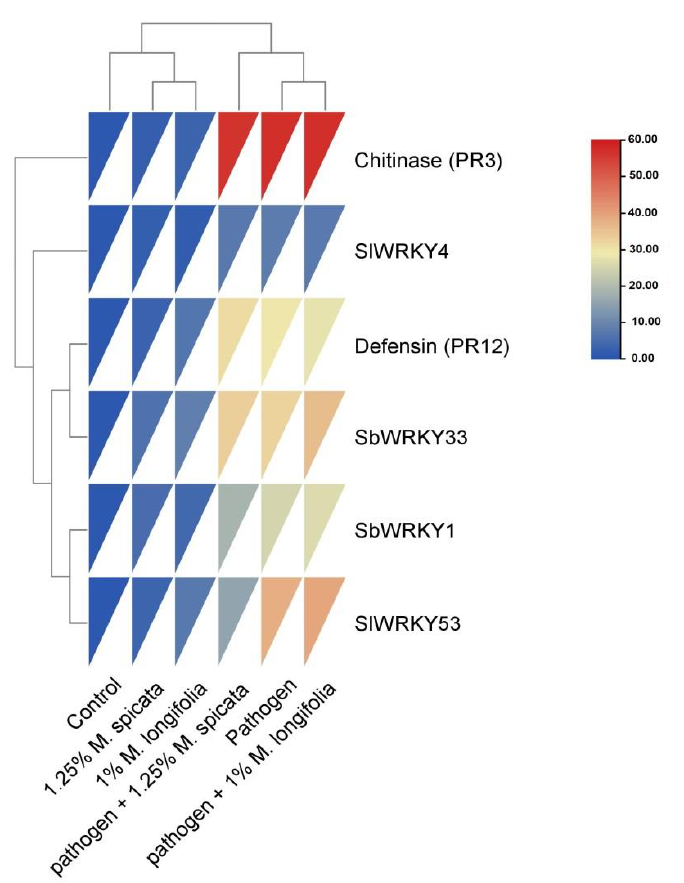
Figure 9. Hierarchical clustering heat map of relative expression levels of chitinase, defensin genes, and WRKY1, WRKY4, WRKY33, and WRKY53 transcripts in L. esculentum seedling under Fusarium injection and application of 1.25% M. spicata and 1.0% M. longifolia EOs treatments.